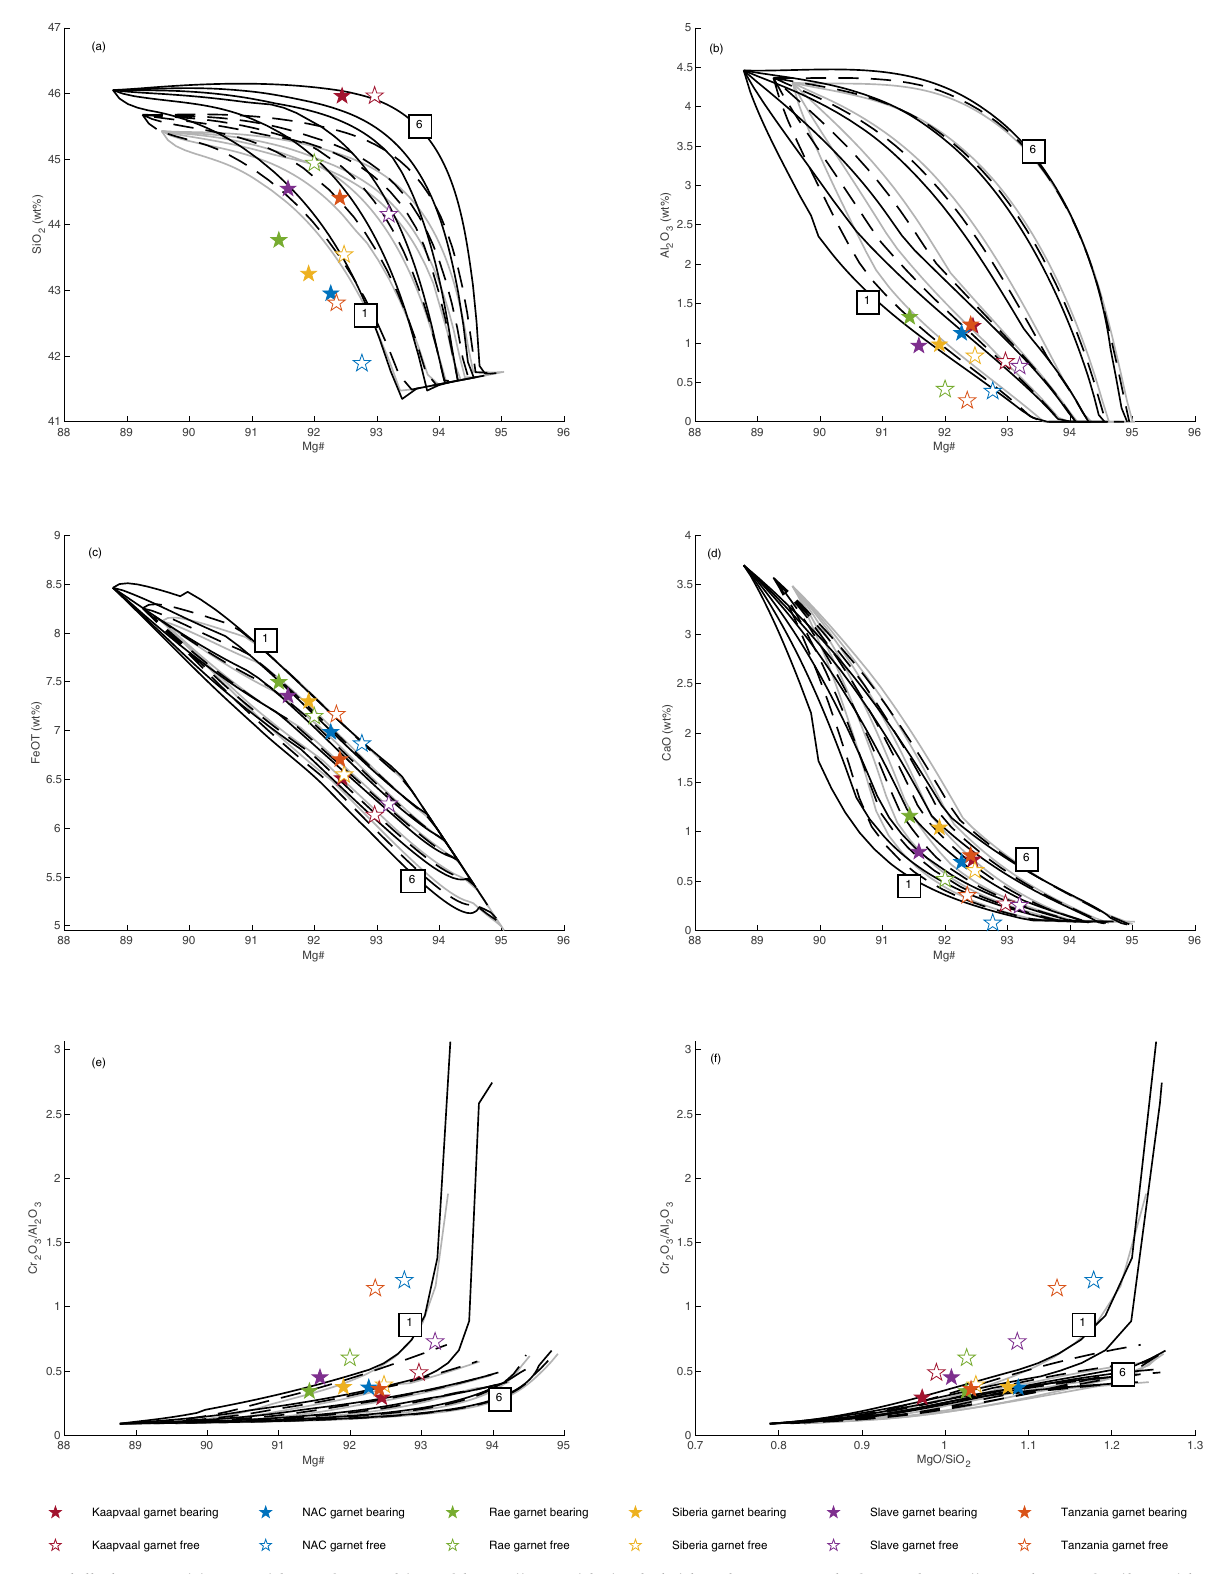
Fig. 6 Modelled compositions residues after melting of komatiite-peridotite hybrid rocks composed of 20% komatiite and 80% fertile peridotite (black dashed lines) and 50% komatiite and 50% fertile peridotite (black solid lines) compared to residues after melting of fertile peridotite (grey lines) from fi gure 3. ( a ) Mg# - SiO 2 , ( b ) Mg# - Al 2 O 3 , ( c ) Mg# - FeO, ( d ) Mg# - CaO, ( e ) Mg# - Cr 2 O 3 /Al 2 O 3 , ( f ) MgO/SiO 2 - Cr 2 O 3 /Al 2 O 3 . Low and high pressures are labelled in GPa. Median compositions of garnet bearing (solid symbols) and garnet free (open symbols) cratonic peridotites were calculated from the literature